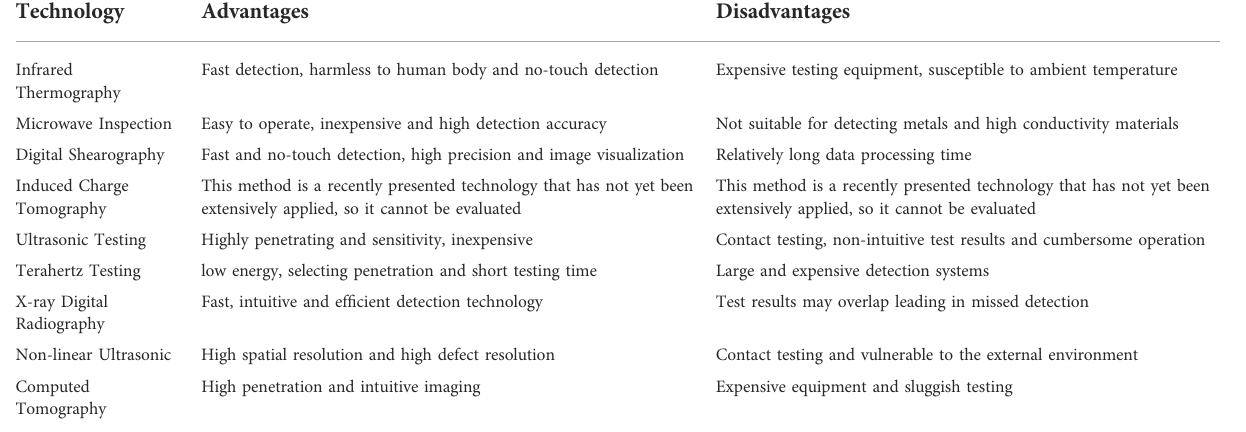
TABLE1 Comparison of advantages and disadvantages of NDT